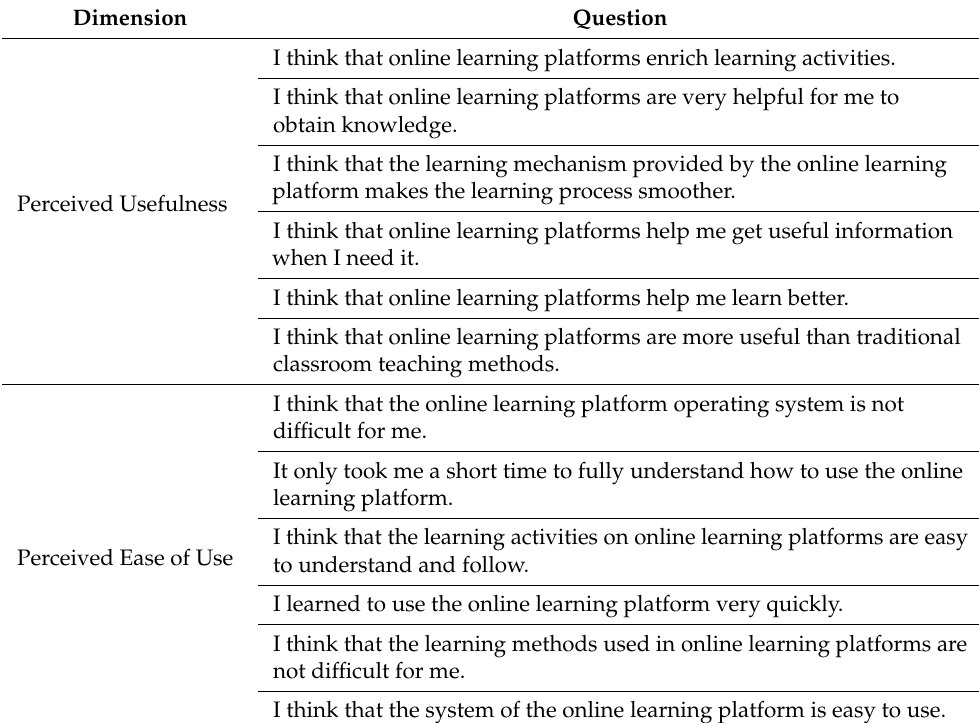
Table 3. Questionnaire items referenced from Hwang et al. [44].